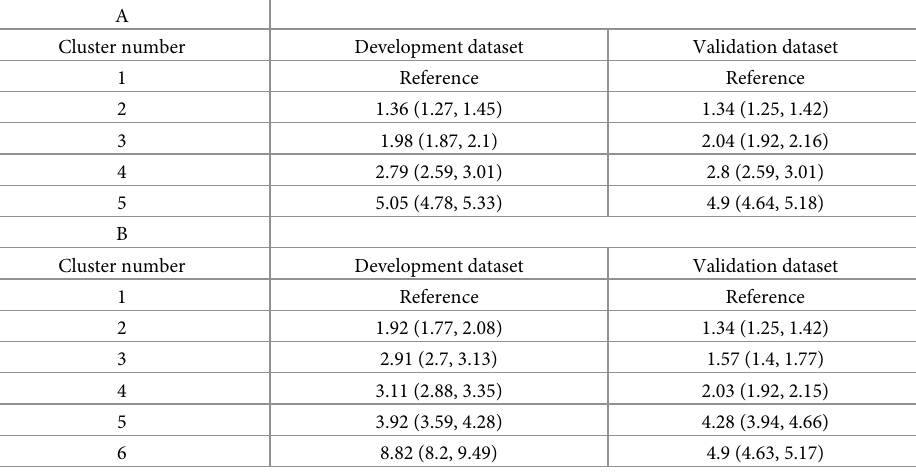
Table 3. Clusters and risk of 5-year